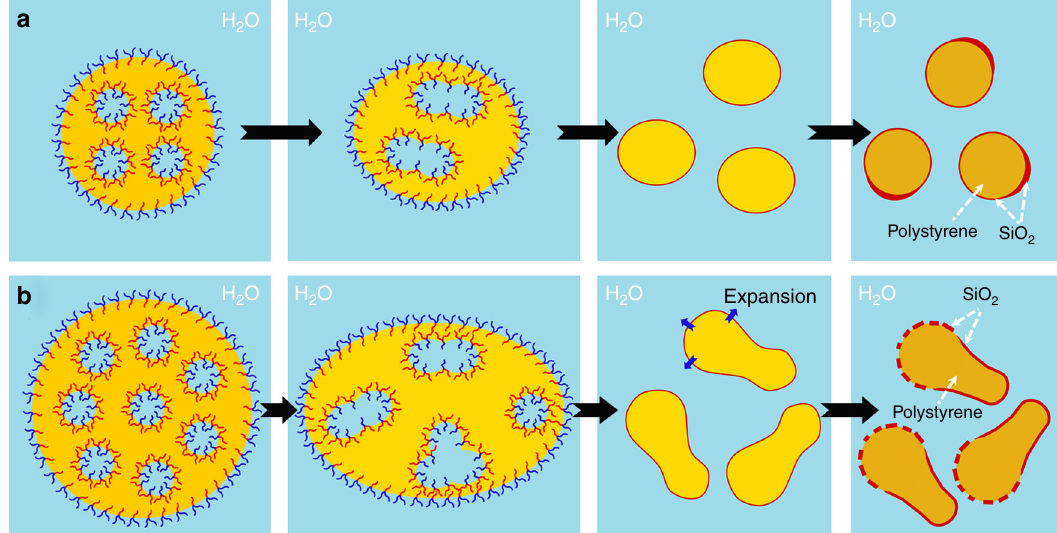
Fig. 6 Oval-shaped nanoparticles and Janus-like nanomushrooms. Emulsion droplets containing multiple water droplets in each oil droplet break up to small nanoparticles upon heating. a Oval-shaped polystyrene@SiO 2 particles are formed from relatively small emulsion droplets that cannot be deformed signi fi cantly by magnetic stirring. b Relatively big emulsion droplets that are largely elongated by magnetic stirring are fragmentized into anisotropic particles, and the recovery of the liquid core to a spherical shape induces the breakage of the already formed silica